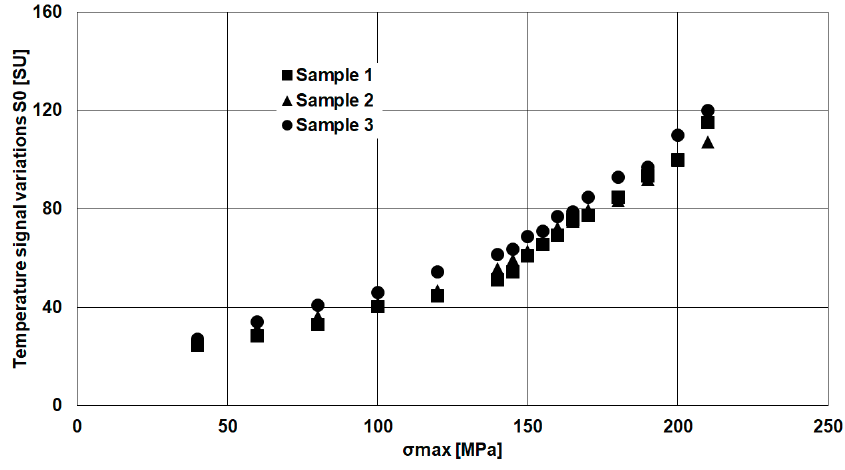
Figure 7. Temperature signal variations ( S 0 ): rough data.